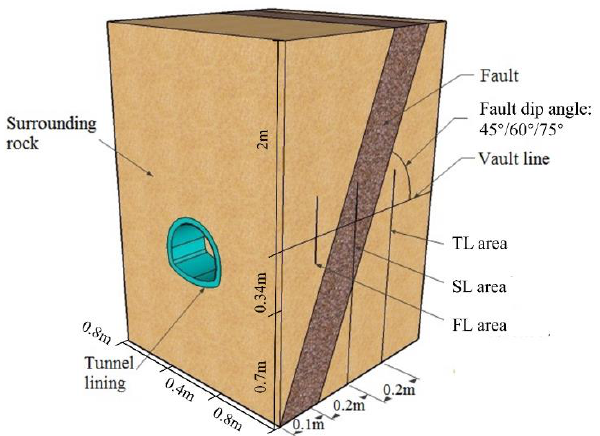
Figure 5. Schematic diagram of the model test.